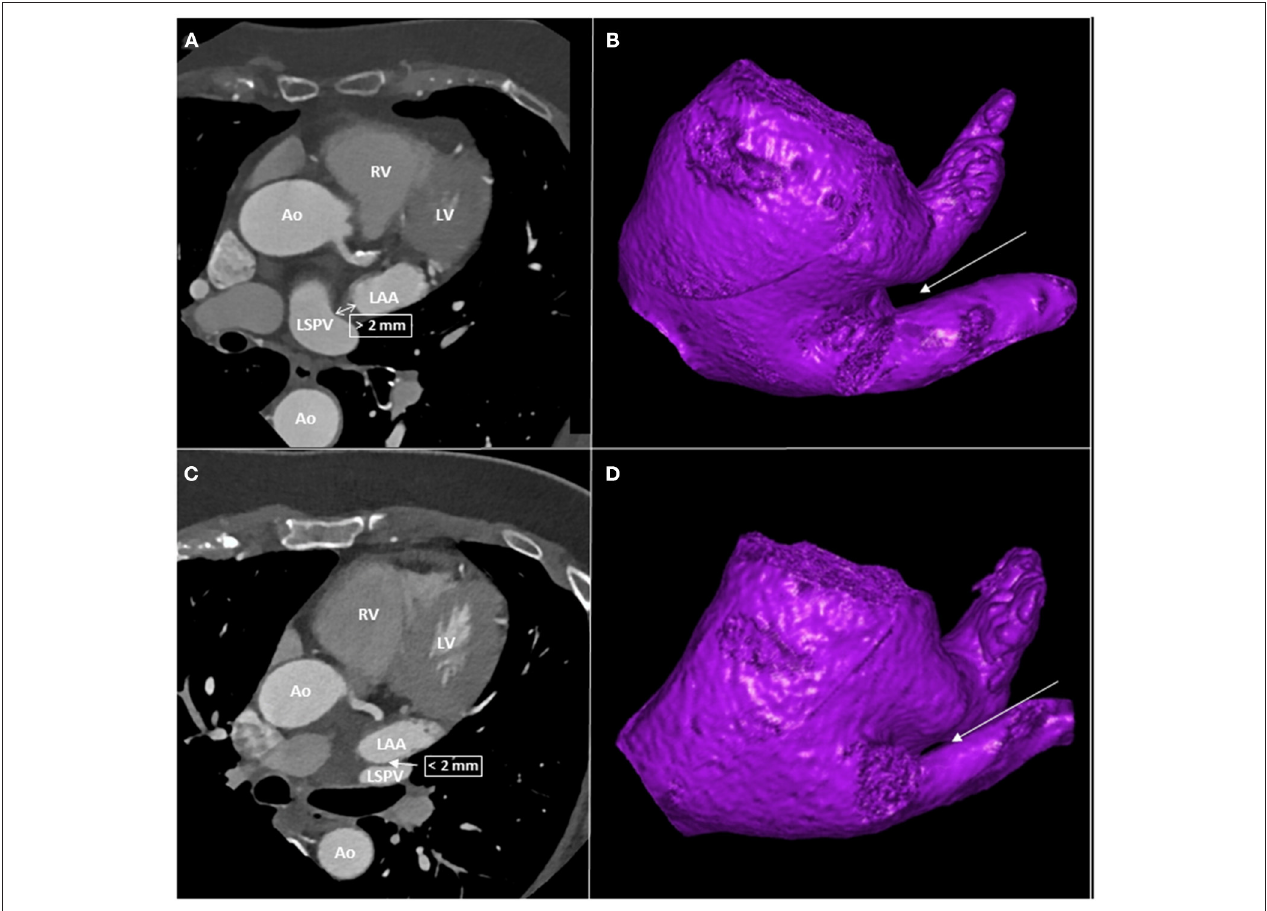
FIGURE 1 | CT images of patients with and without abutting LAA-LSPV. (A) left atrial CT of a patient with non-abutting LAA-LSPV. (B) three-dimensional reconstruction of left atrium from caudal view, with a highlight on non-abutting LAA-LSPV. The LIPV was removed to give a better visualization of the LSPV. (C) left atrial CT of a patient with abutting LAA-LSPV. (D) three-dimensional reconstruction of left atrium from caudal view, with a highlight on abutting LAA-LSPV. The LIPV was removed to give a better visualization of LSPV. The arrows indicate the site of distance measurement between LAA and LSPV. Ao, aorta, CT, computed tomography, LAA, left atrial appendage, LV, left ventricle, LIPV, left inferior pulmonary vein, LSPV, left superior pulmonary vein, RV, right